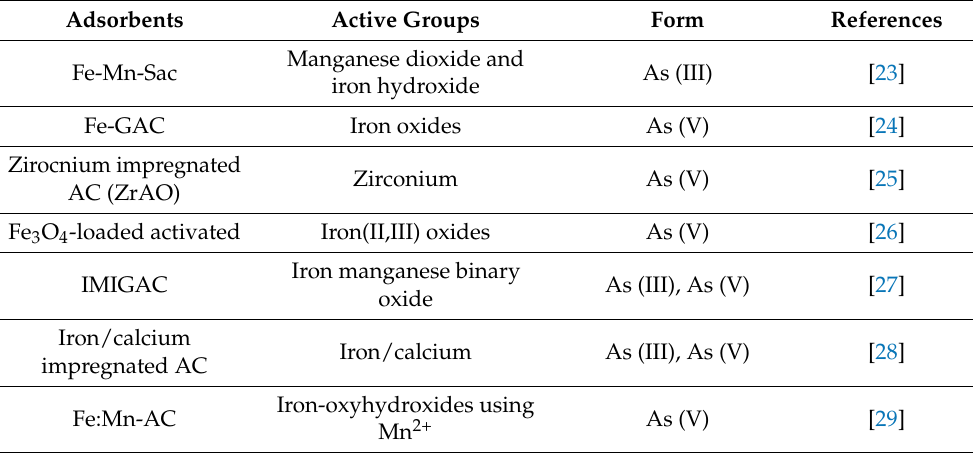
Table 1. Comparison of major active groups that have been used to modify activated carbons applied for arsenic